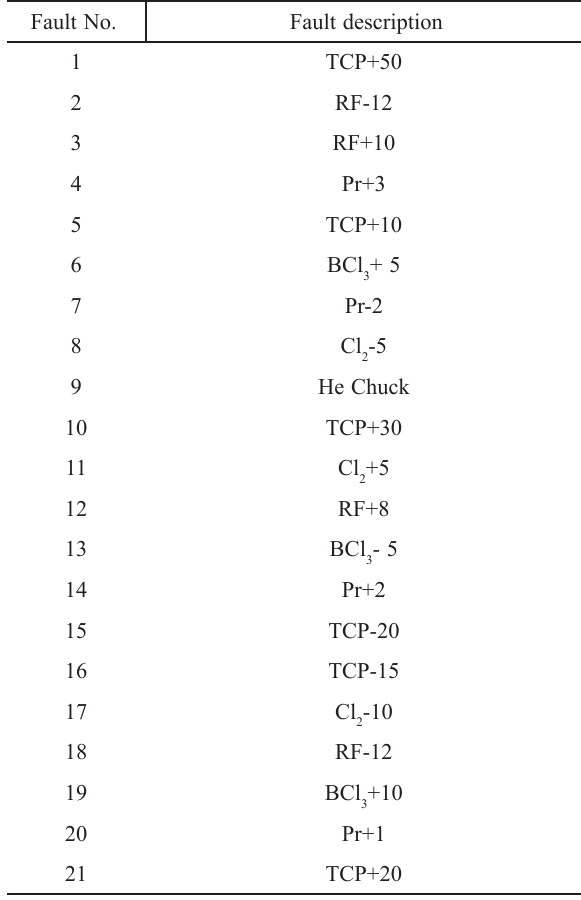
Table 2 – Fault types detected in the metal etching process 3